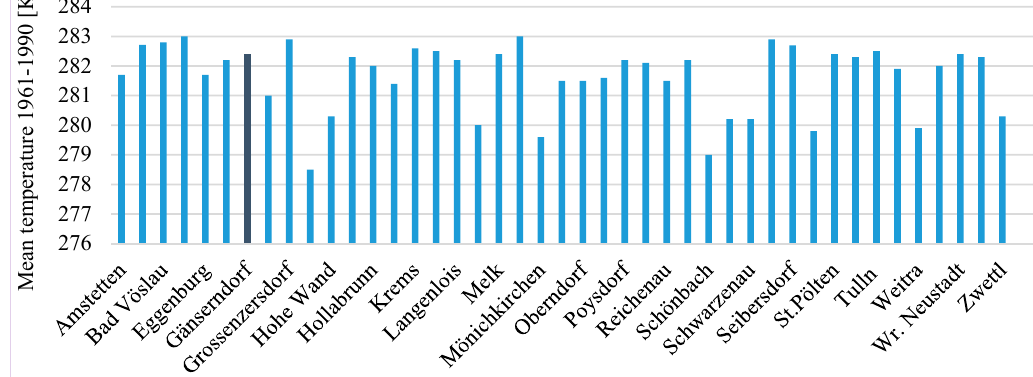
Figure 8. Mean temperature in the period 1961–1990 (K) for weather stations in Lower Austria.